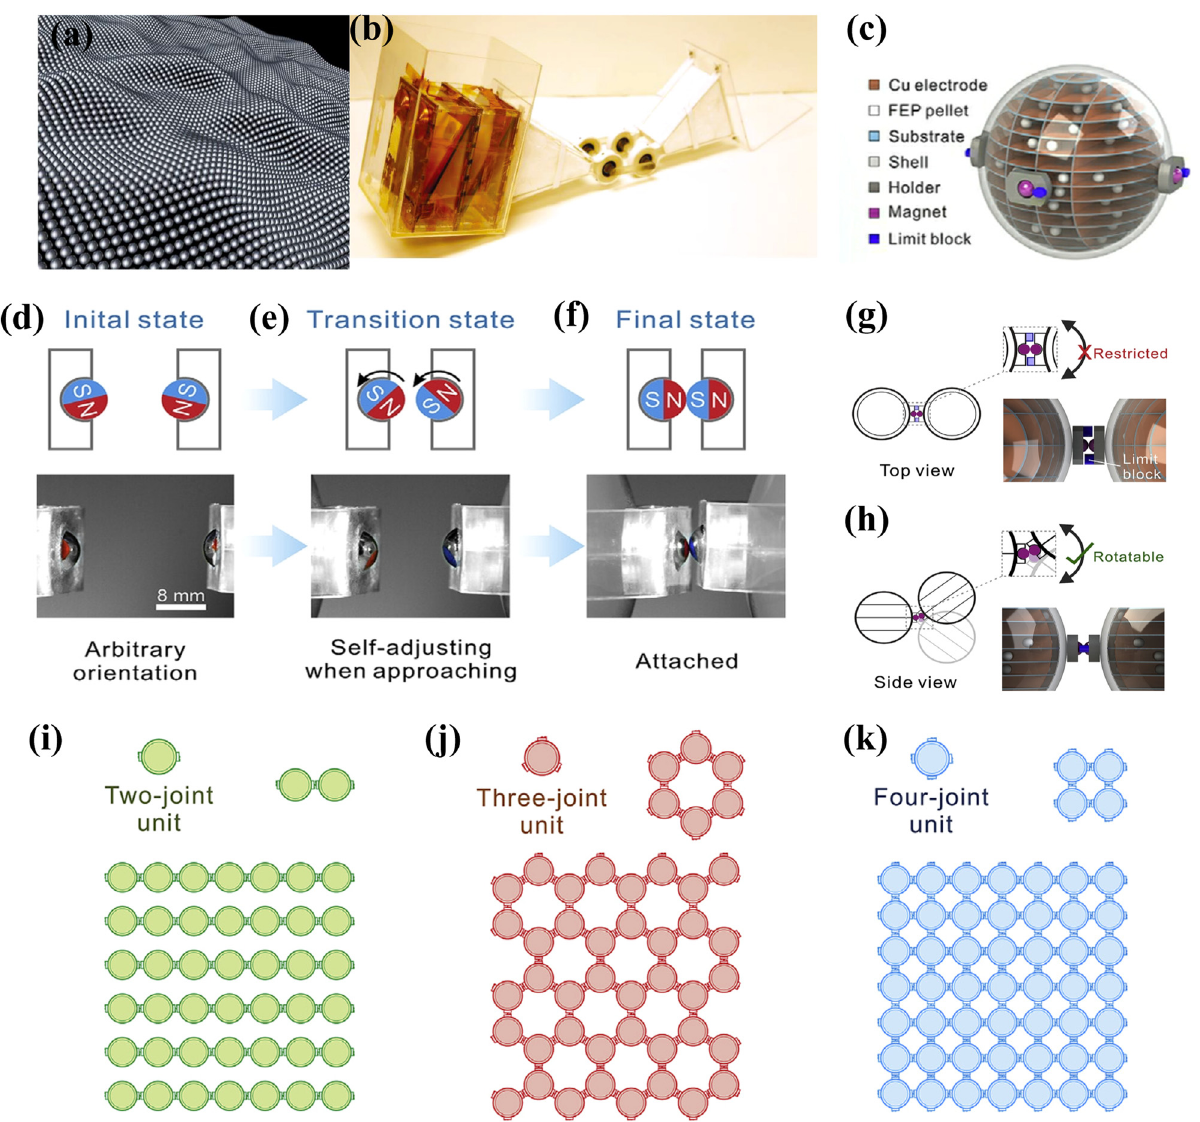
Figure 11: ( a ) A proposed TENG network composed of tens of thousands of spherical ball based TENG units for harvesting ocean wave energy [ 25 ] , ( b ) a hinged connection structure of the TENG network [ 88 ] , ( c ) schematic structure of the self - assembly TENG unit, ( d – f ) principle of SAM - joints transfer without limit block, ( g and h ) assembly diagram of SAM - joints with limit block, and ( i – k ) schematic diagram of di ff erent assembly shapes [ 55 ]